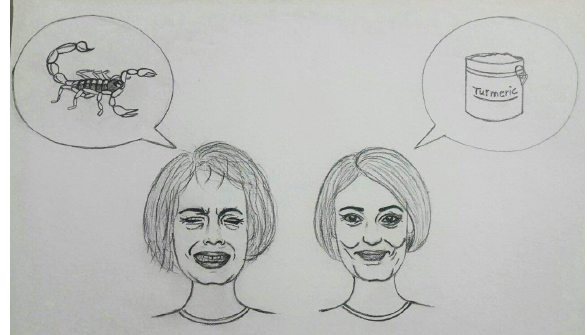
Figure 1. A woman that induces a factitious disorder for achievement of primary gain. She has preoccupation with damage to skin. She indicate that it is bitten by the scorpion